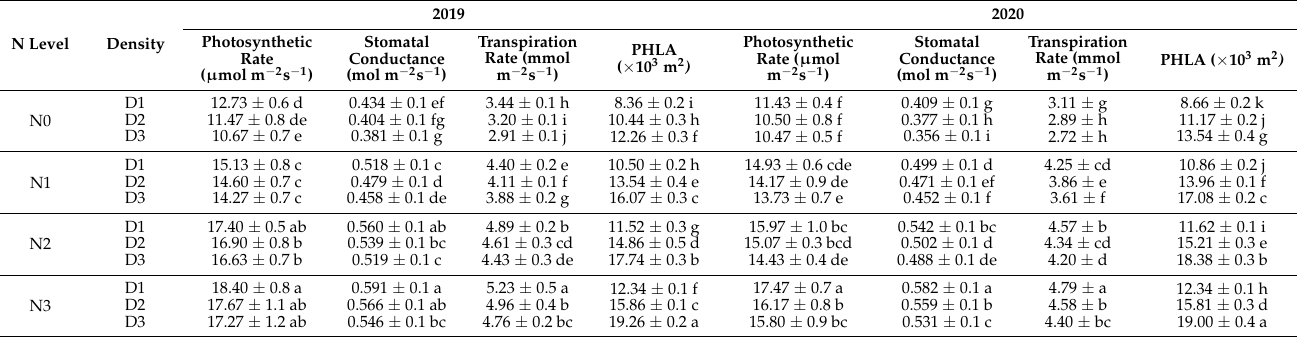
Note: Means ± SD followed by different letters in the same column indicate a significant difference ( p < 0.05). Four N fertilization levels—N0: 0 kg ha − 1 ; N1: 120 kg ha − 1 ; N2: 180 kg ha − 1 ; N3: 240 kg ha − 1 . Three plant densities—D1: 180 × 10 4 basic seedlings ha − 1 ;